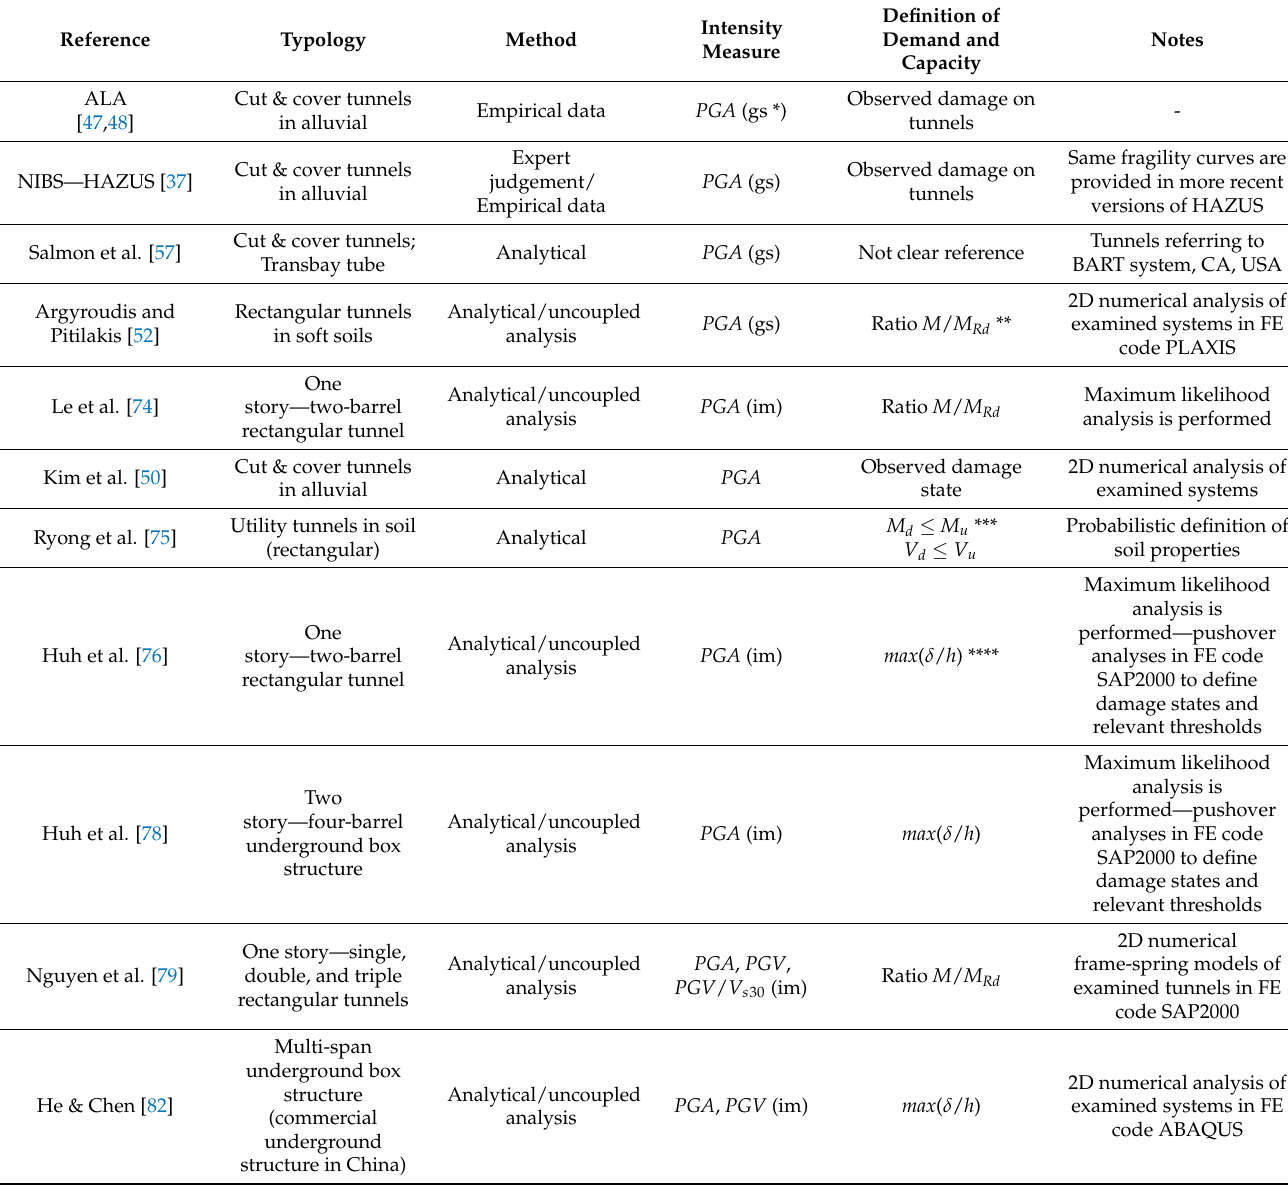
Table 4. Studies on seismic fragility assessment of cut and cover tunnels/subway stations/rectangu- lar underground structures subjected to ground seismic shaking in the transversal direction.